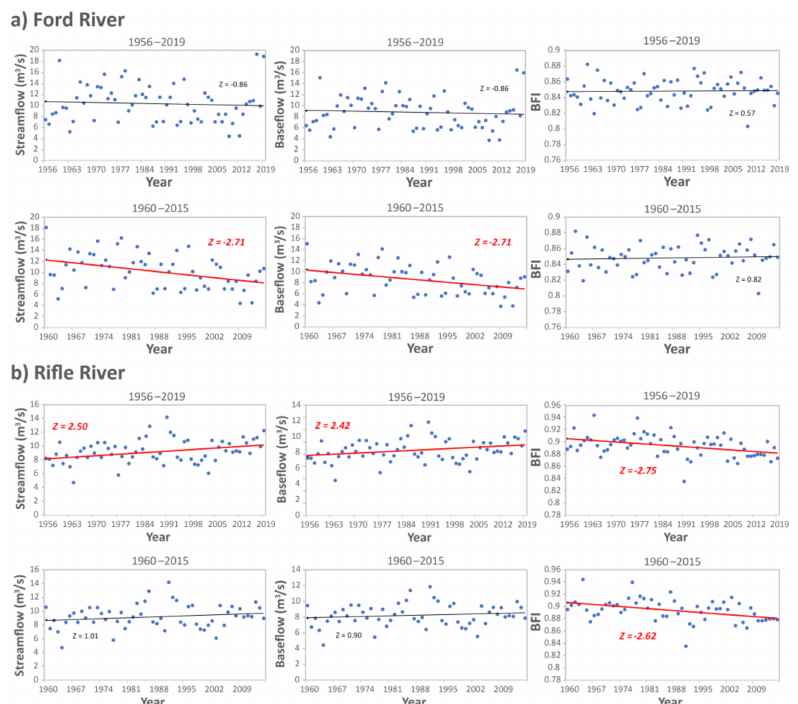
Figure 7. Annual trends in streamflow (left panel), baseflow (mid panel) and BFI (right panel) for Ford River ( a ) and Rifle River ( b ) long-term monitoring sites. Z values reflect results from block bootstrapped Mann–Kendall (MK) test. Significant trends are highlighted in red. Note the consistent trends for BFI and inconsistent trends for streamflow and baseflow for the different time periods: 1956–2019 (this study) and 1960–2015